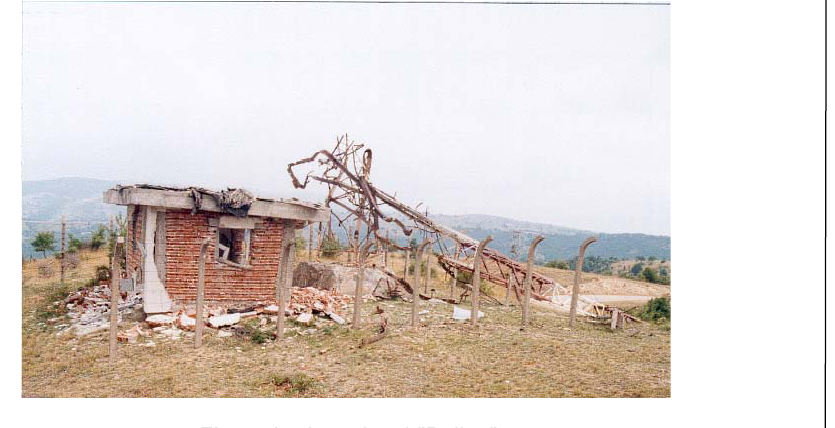
Figure 6 – Location 4 "Reljan" Рисунок 6 – Локация 4 « Релян » Слика 6 – Локација ‒ 4 „ Рељан